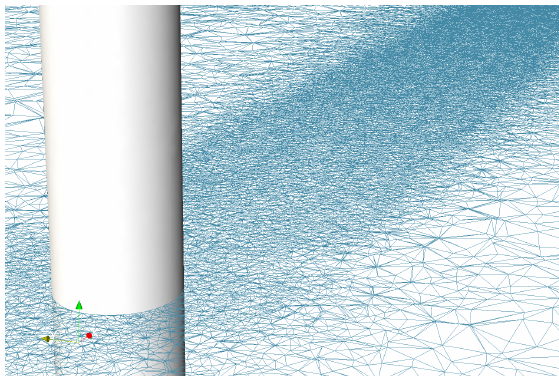
Figure 5. Close up of a horizontal slice through the mesh at hub-height, showing the mesh resolution around and downstream of the cylinder. The resolution of the mesh at the cylinder’s surface is 0.25 m; this increases to approximately [2 m, 2 m, 1 m] over a distance of 10 m upstream, 20 m cross-stream and 250 m